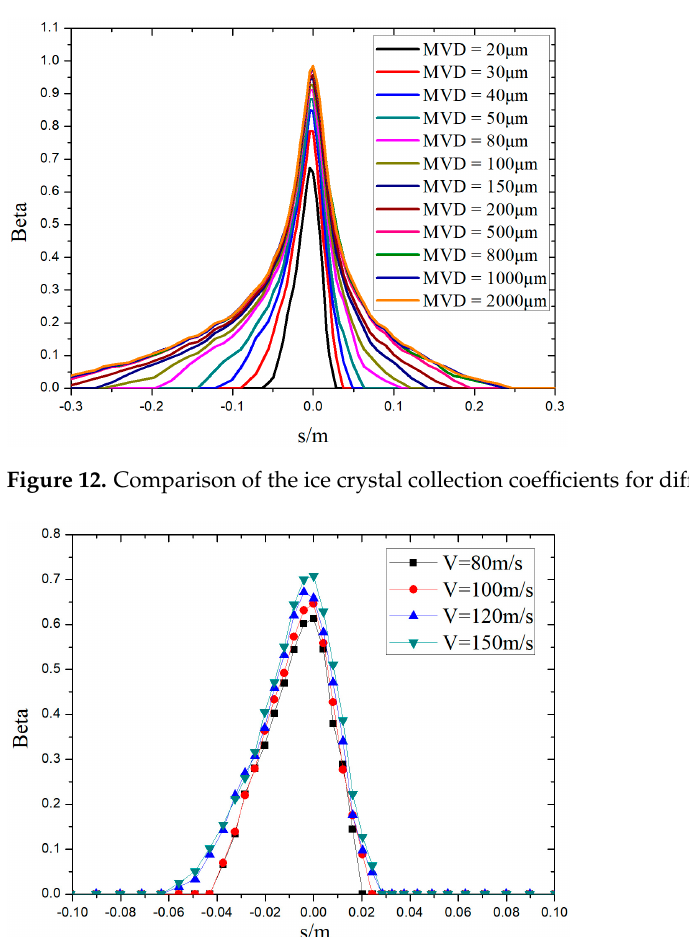
Figure 13. Comparison of the ice crystal collection coe ffi cients for di ff erent in fl ow velocities.